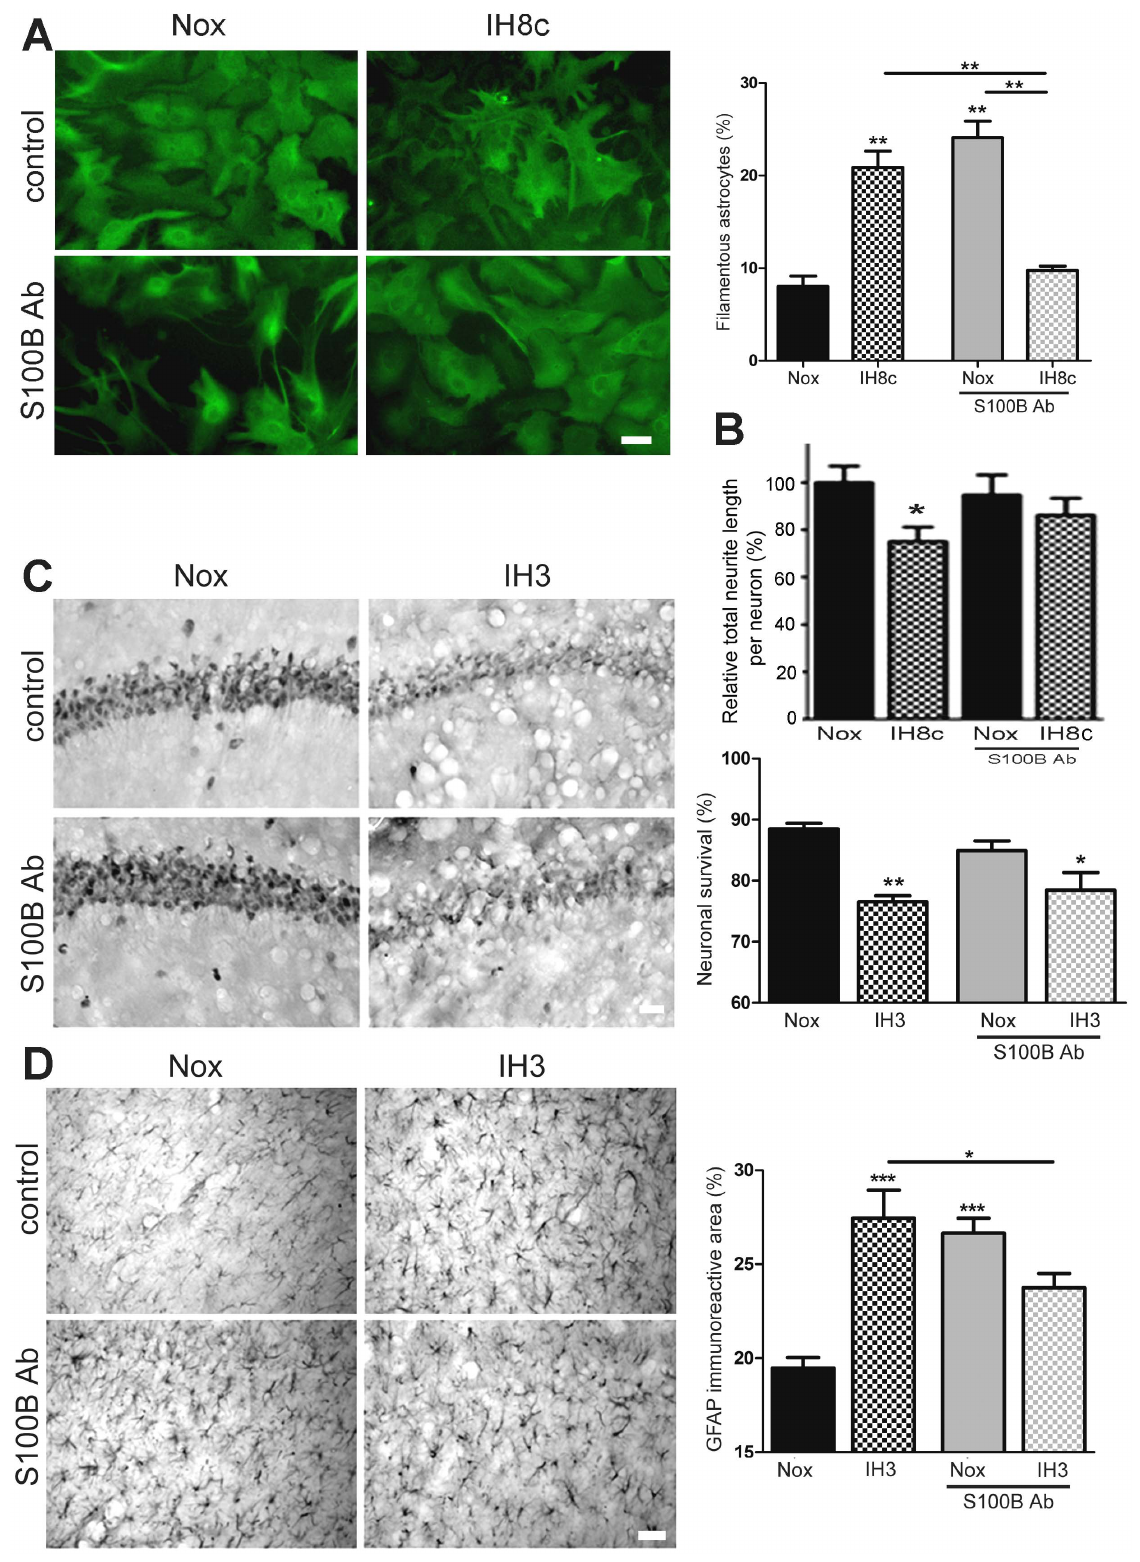
Figure 3. S100B blockage reduced astroglial stellation in vitro and reactive gliosis in vivo. A: GFAP immunostained astrocytes in dissociated mixed hippocampal cell cultures after 8 cycles of IH exposure (IH8c) in the absence or presence of S100B blocking antibodies (1 m g/ml), bar =23 m m (left). Percentage of filamentous astrocytes was evaluated in the same cultures using the ImageJ cell counter plugin and referred to the total number of GFAP + cells (right). B: Relative neurite length per neuron in the dissociated mixed hippocampal cell culture after 8 cycles of IH